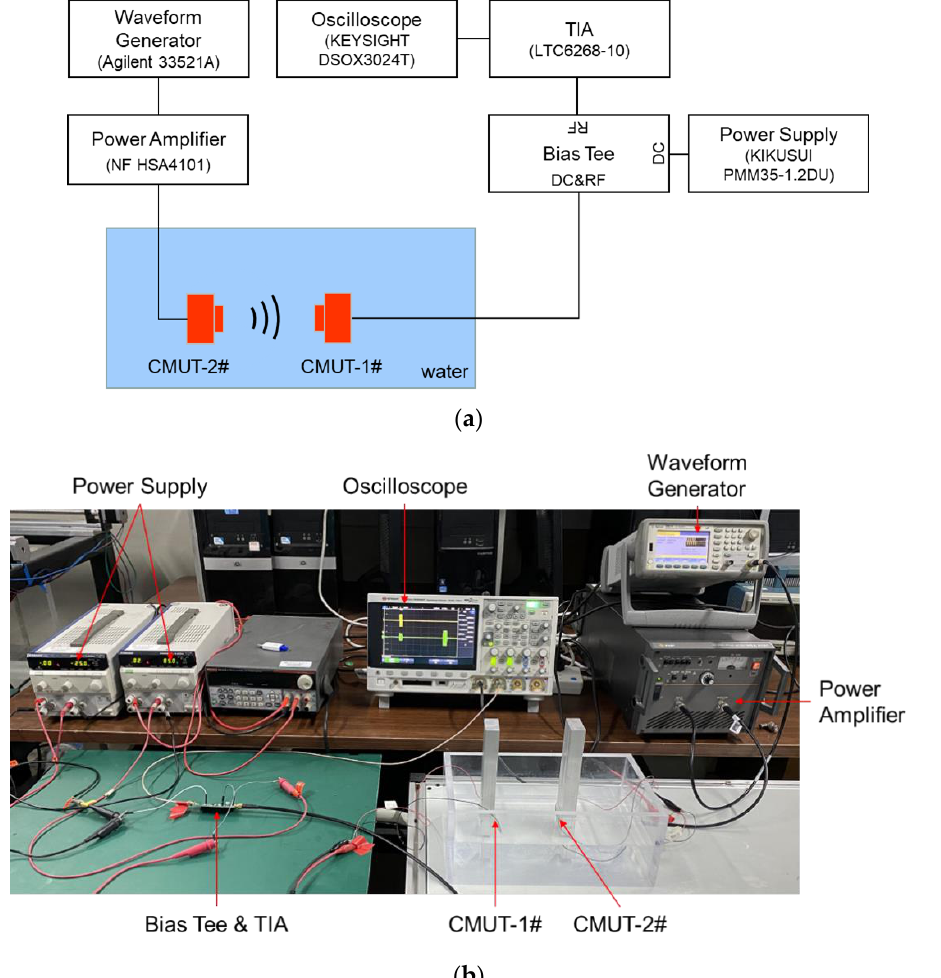
Figure 8. ( a ) Schematic of the measurement setup of the CMUT receiving performance; ( b ) photograph of the measurement setup.